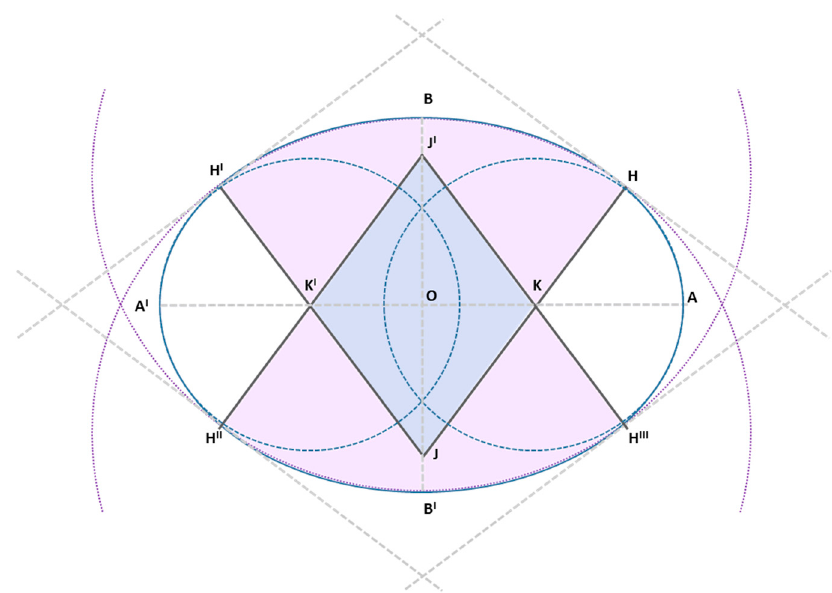
Figure 9. A polycentric oval with four centres, aligning the major and minor axes and with tangents at their connecting points, as defined by basic characteristics. The raised number behind the letters indicate the double symmetry.